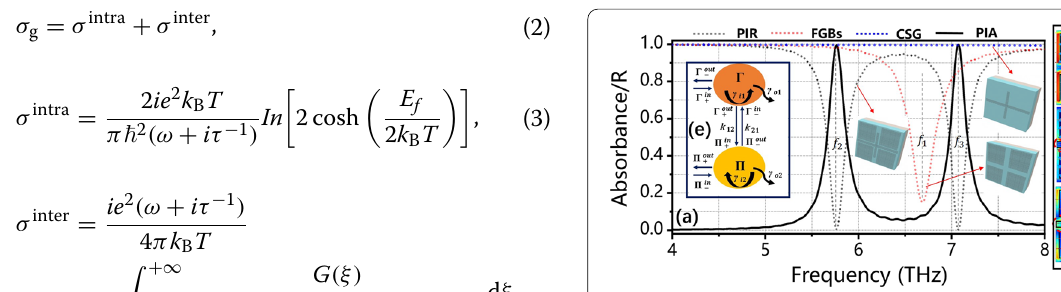
Fig. 2 a Reflection and absorption spectrum of the PIR and PIA at E f 1.0 eV. b – d The electric field distribution at f 1 = f 2 5.758 THz and f 3 7.064 THz, respectively. e The theoretical = = coupling between resonant